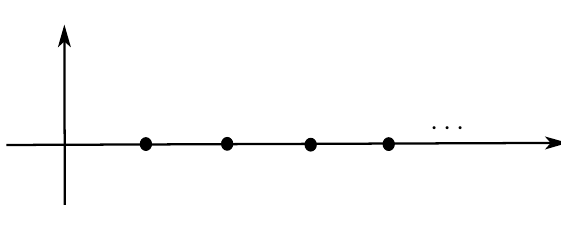
Figure 8 . The Borel transform (2.80) has poles of order ‘ + 1 at all positive integers ‘ = 1 ; 2 ; The ‘ -th singularity leads to an exponentially small correction exp (